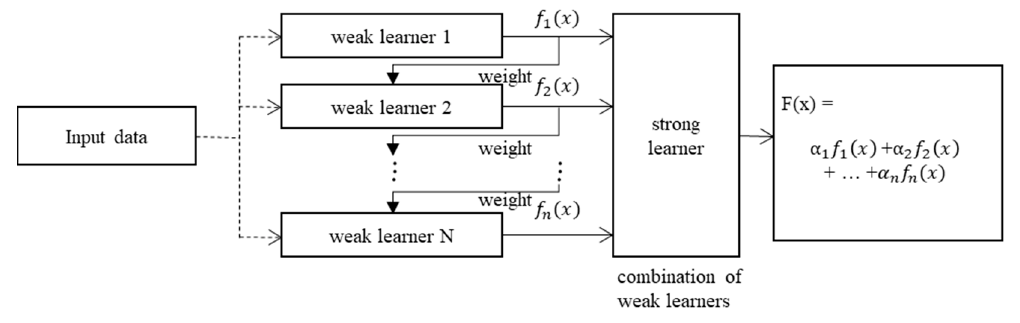
Figure 6. Procedure of an ensemble from an input sample.